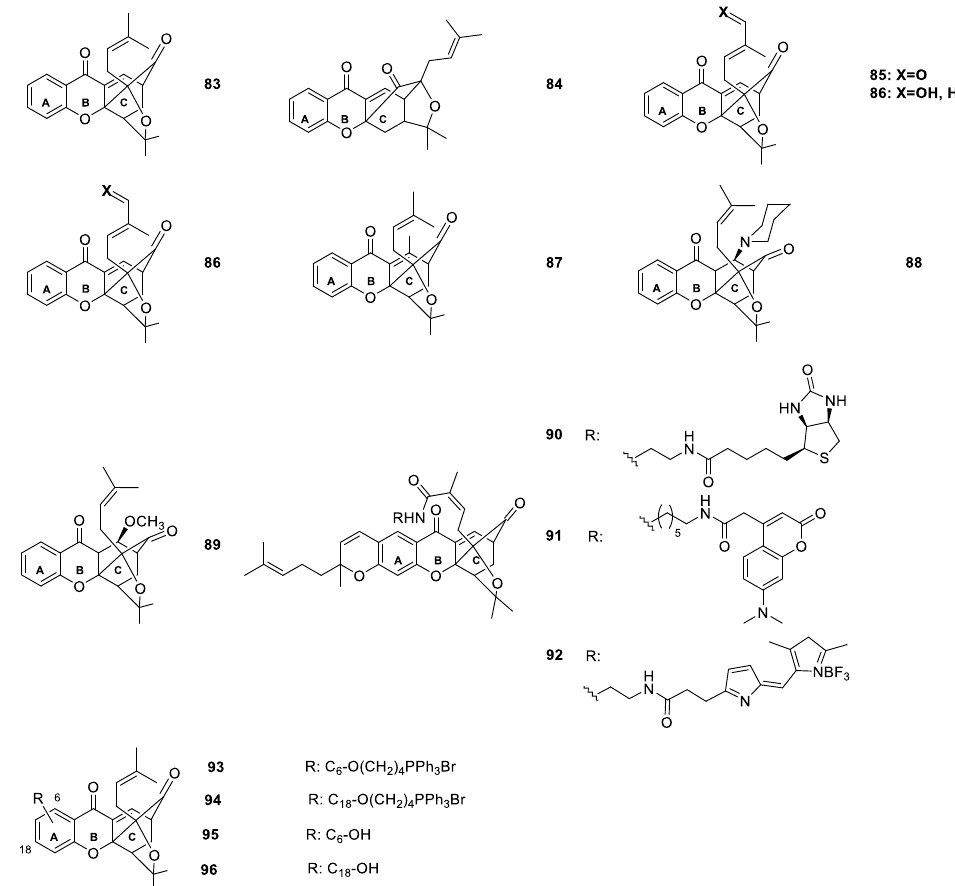
Figure 10. Structures of caged xanthone 83 – 96 , with antimalarial and antitumor activities.